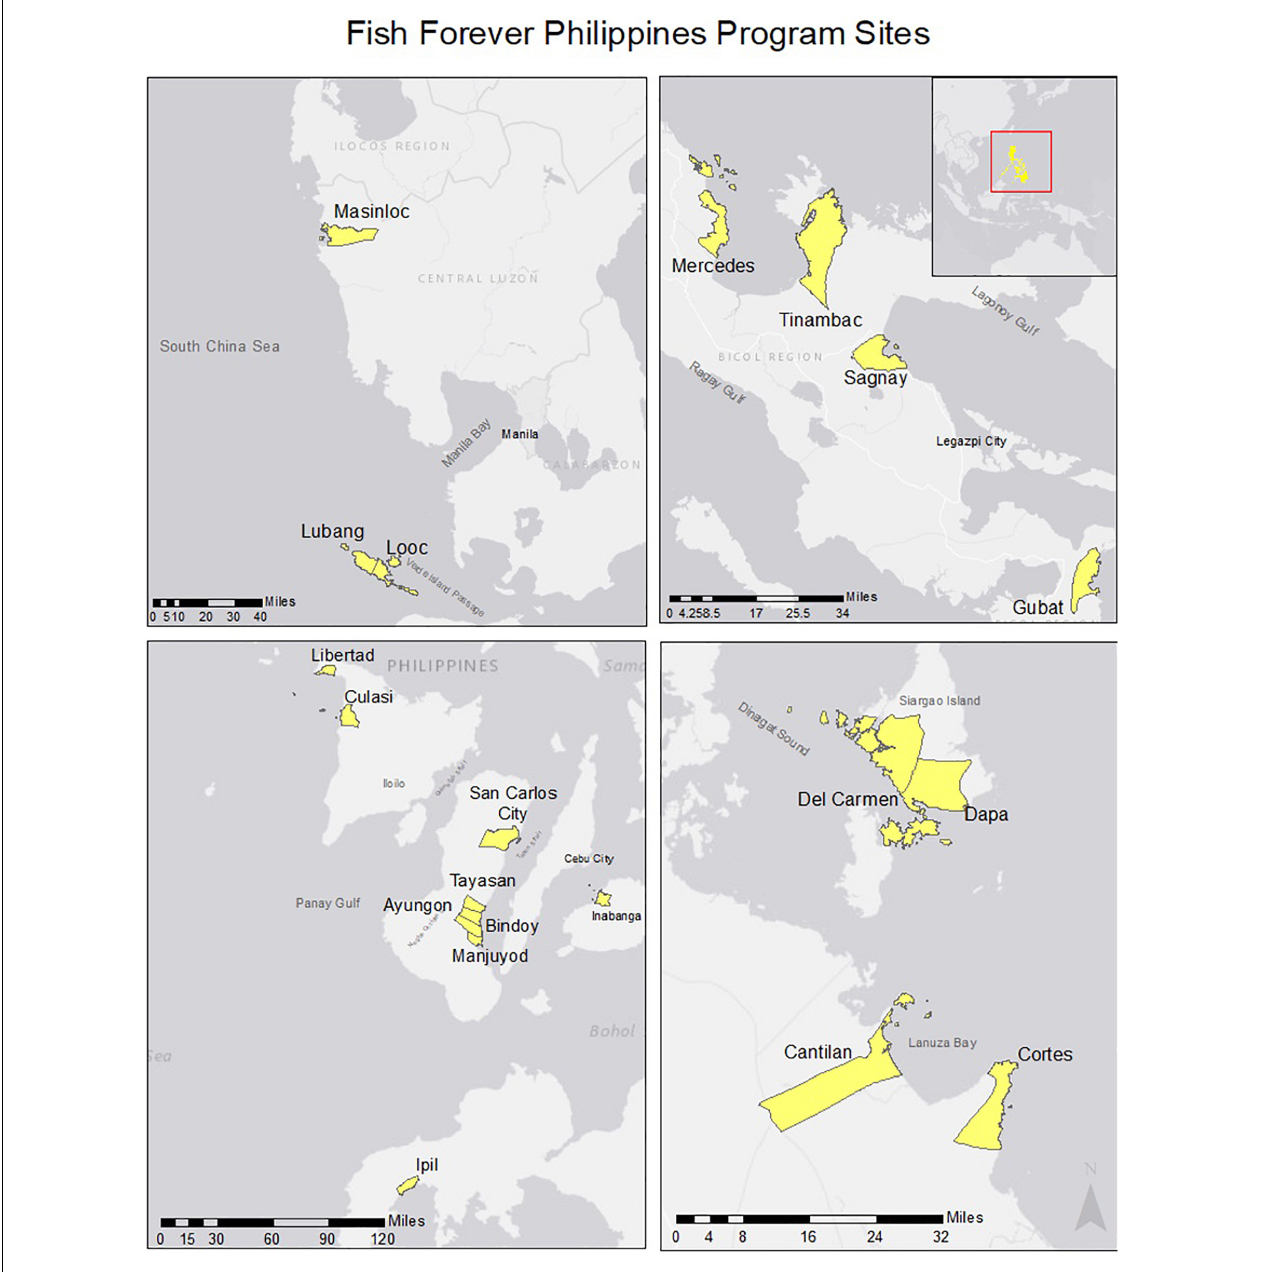
FIGURE 1 | Site Map of the 20 Fish Forever program sites where marine reserves are located. Data Source: GADM, Spatial Reference: GCS WGS 1984.